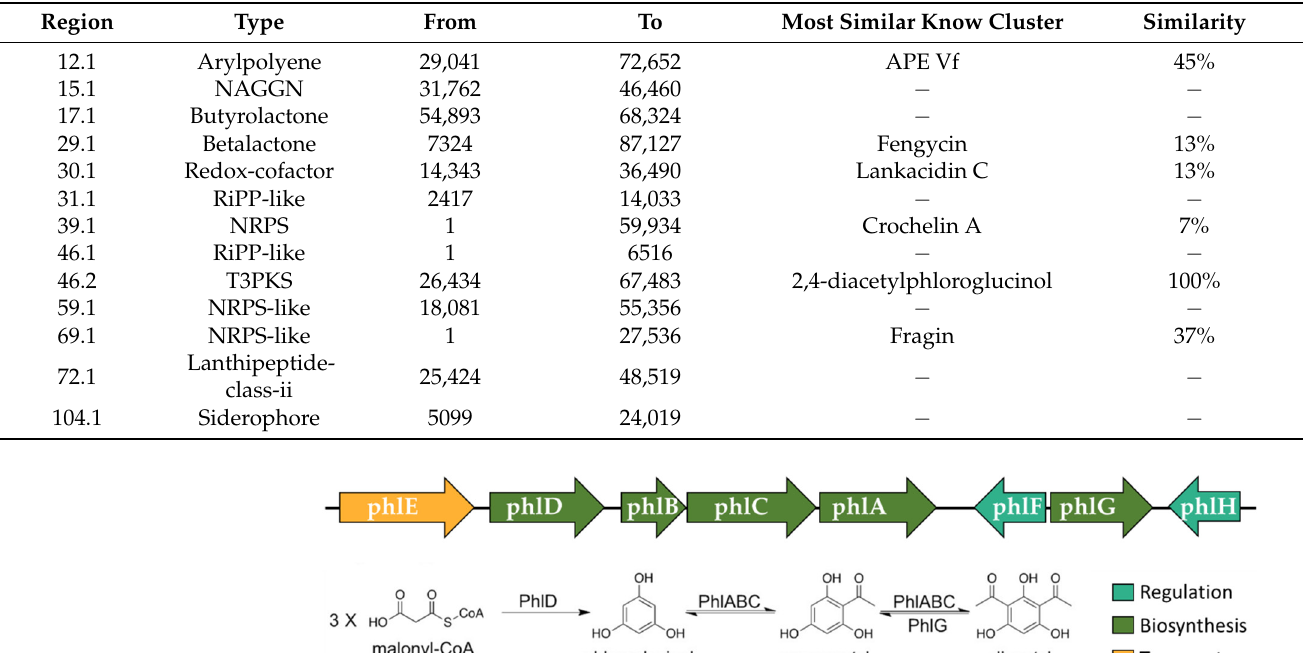
Table 2. Secondary metabolites identified in Pseudomonas sp. strain C3.